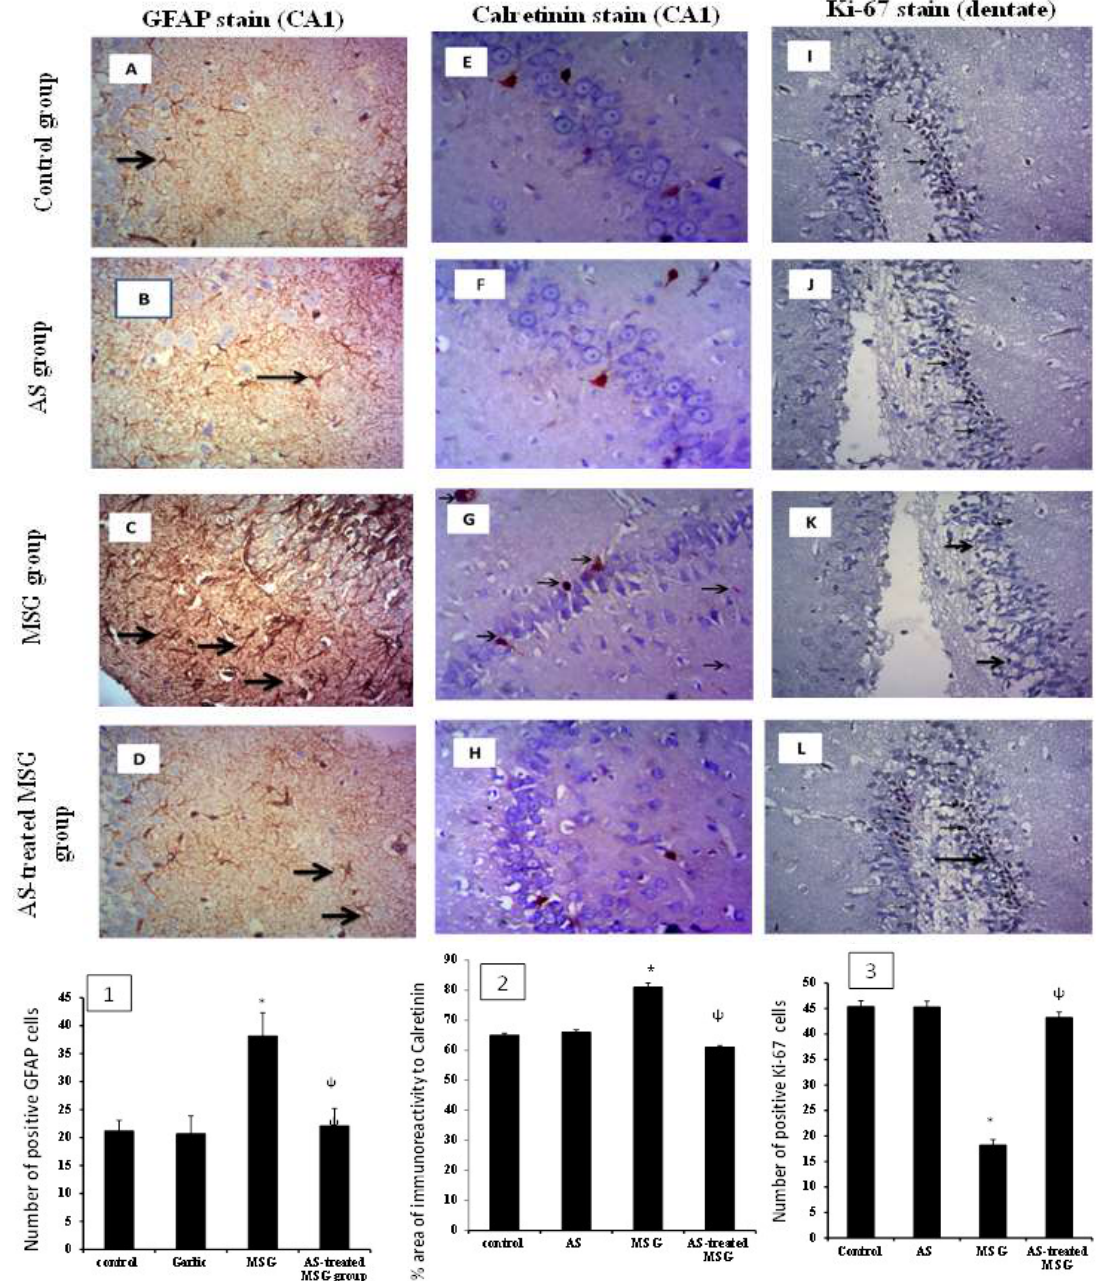
Figure 6. Light microscopic examination of glial fibrillary acidic protein (GFAP)-stained sections of CA1 in the hippocampus ( A – D ) showing strong positive immune staining in MSG group compared with the control and AS groups. AS-treated MSG group showed weak reaction (arrows) (GFAP X400). Calretinin-stained sections of CA1 in the hippocampus ( E – H ) showed weak immune positive reactive neurons in control, AS, and AS-treated MSG groups, but MSG group showed strong positive reactive neurons (arrows) (Calretinin X200). Additionally, light microscopic examination of Ki-67-stained sections of the dentate of hippocampus ( I – L ) showed marked positive immune stain in the sub-granular zone (arrows) in the control and AS groups. The number of Ki-67 immunoreactive nuclei was significantly decreased in the MSG group compared to the control group. AS-treated MSG group was more or less like the control group (Ki-67 X400). * p < 0.05, vs. control; ψ p < 0.05, vs. MSG.